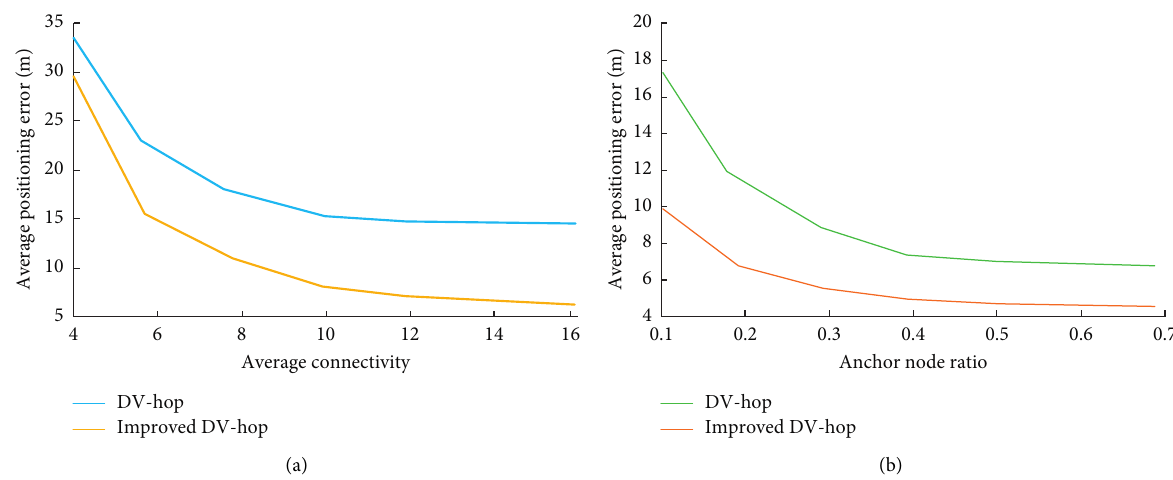
Figure 5: Comparison results of node positioning errors measured under different connectivity and different anchor node proportion.